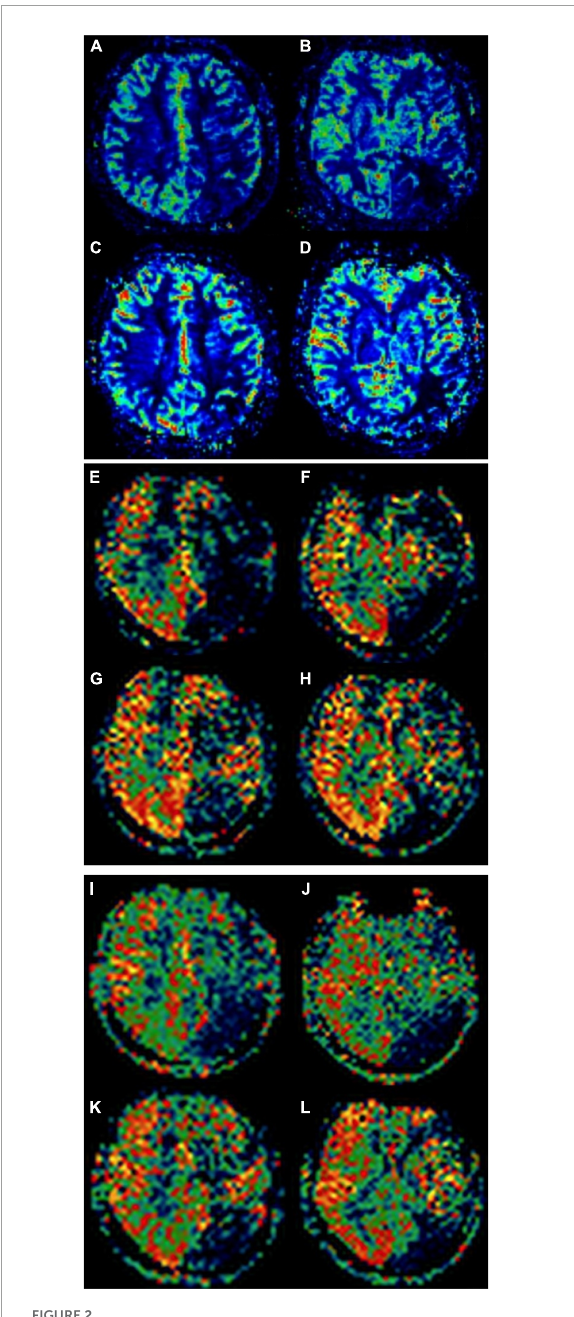
FIGURE2 A 51-year-old female patient with moyamoya disease (MMD) underwent encephaloduroarteriosynangiosis (EDAS) on the left side. Alberta Stroke Program Early CT Score (ASPECTS) area ischemia scores of dynamic susceptibility contrast-cerebral blood flow (DSC-CBF) before revascularization were 5 points (A,B) . ASPECTS area ischemia scores after revascularization were 8 points (C,D) . ASPECTS area ischemia scores of arterial spin labeling (ASL)-CBF (1,500 ms) before revascularization were 5 points (E,F) . ASPECTS area ischemia scores after revascularization were 9 points (G,H) . ASPECTS area ischemia scores of ASL-CBF (2,500 ms) before revascularization was 4 points (I,J) . ASPECTS area ischemia scores after revascularization were 8 points (K,L)